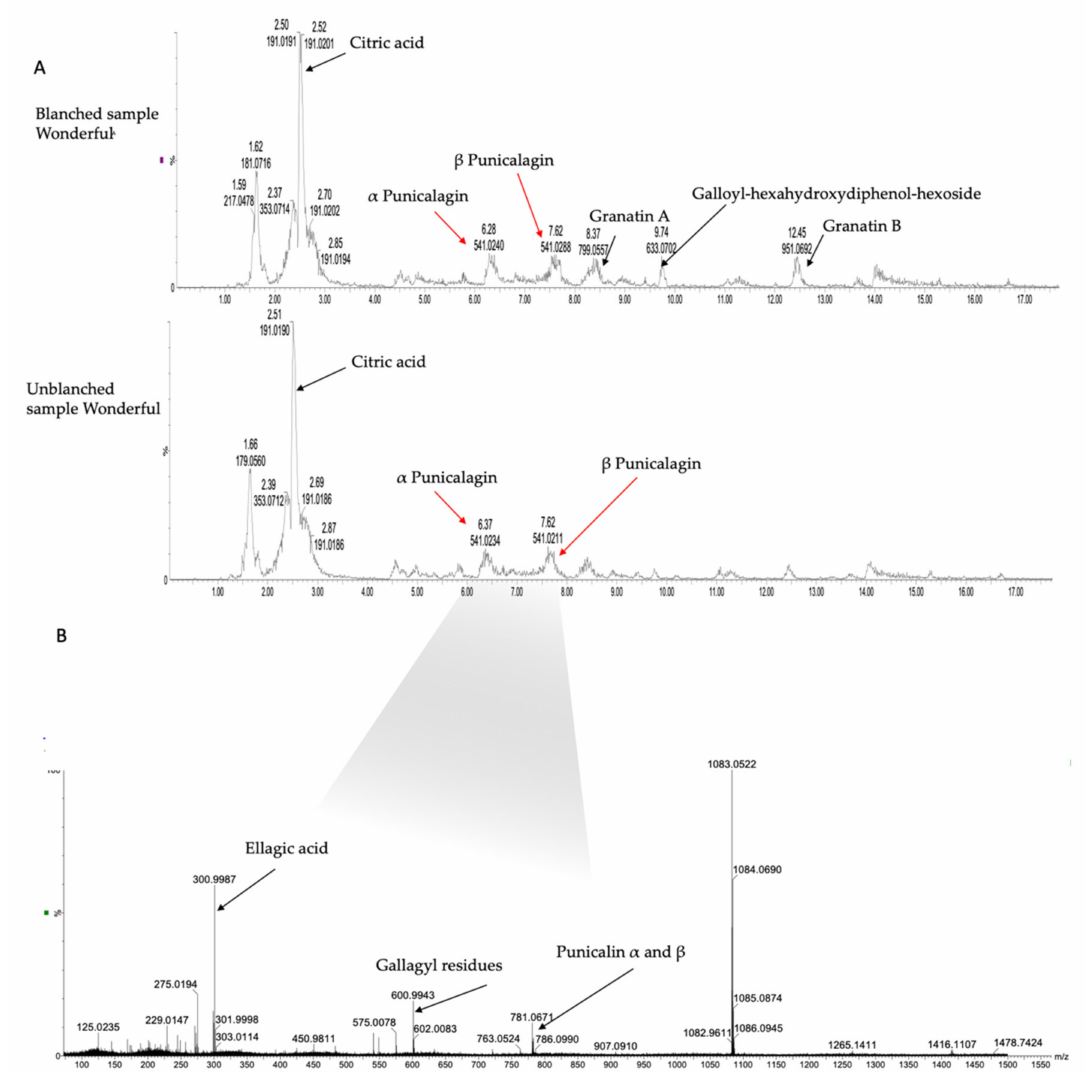
Figure 2. Metabolite profiling of peel extracts. ( A ) An example of a LC-MS chromatographic separation of blanched and unblanched pomegranate peels. ( B ) MS E fragmentation patterns of studied pomegranate peels showing the main fragments observed in punicalagin compounds (punicalin α and β (781.0671 m / z ), gallagyl residues (600.9943 m / z ) and ellagic acid (300.9987 m / z